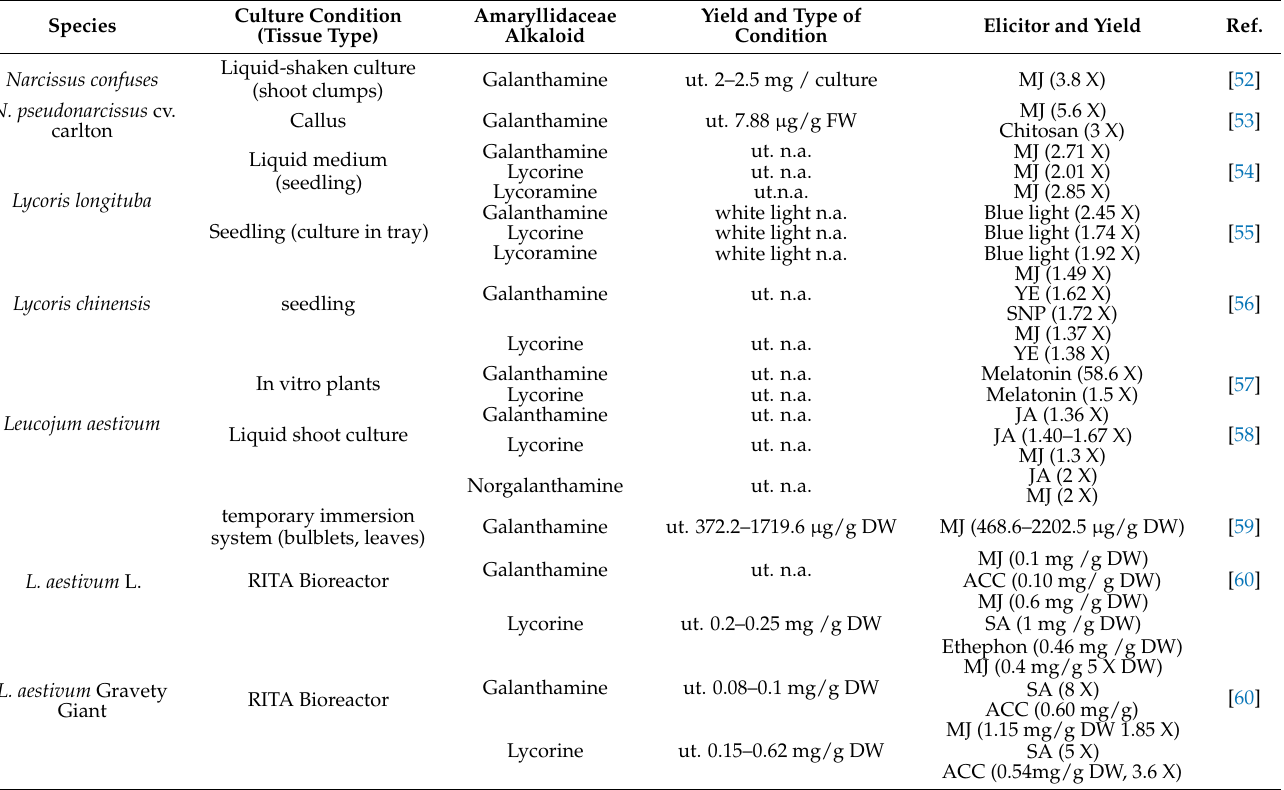
Table 2. Production of Amaryllidaceae alkaloids in in vitro cultures following elictor